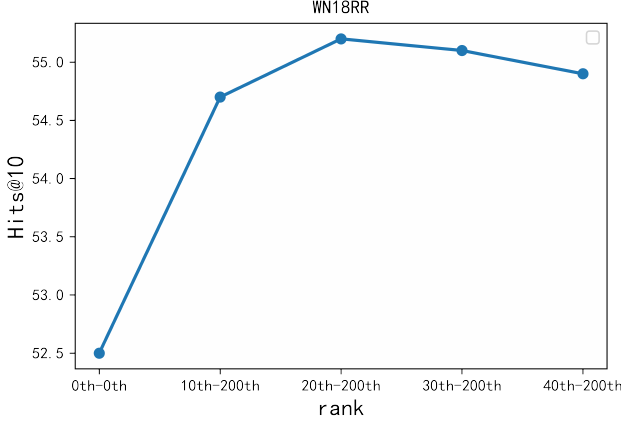
Figure 5. Experimental results on WN18RR, evaluated in terms of Hits@10 for rank ( r s - r t ) ∈ { 0th- 0th, 10th-200th, 20th-200th, 30th-200th, 40th-200th }